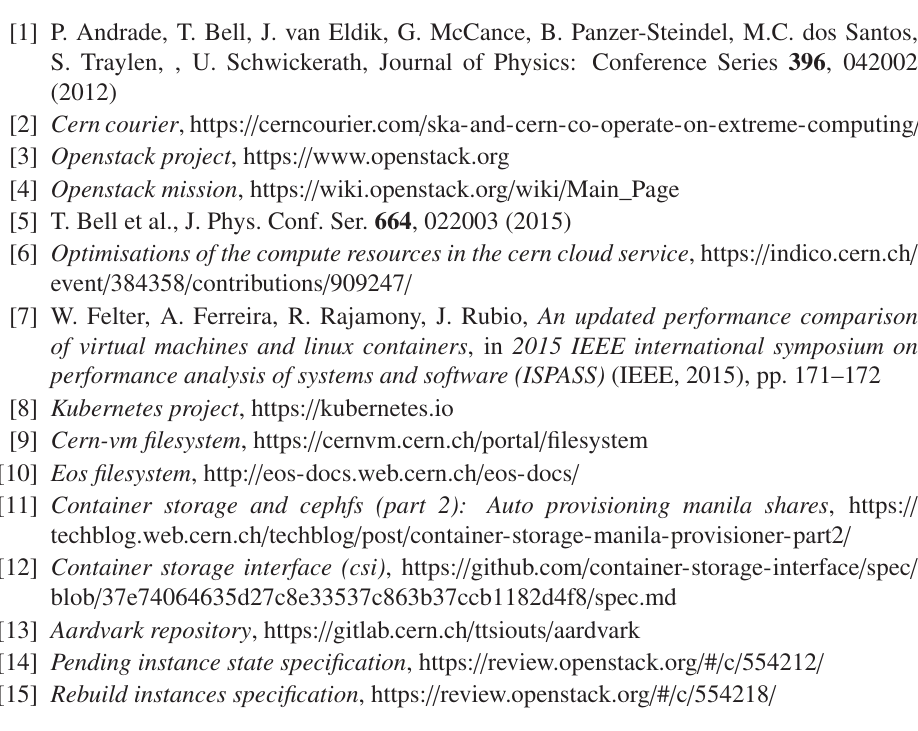
Figure 1. The Aardvark service